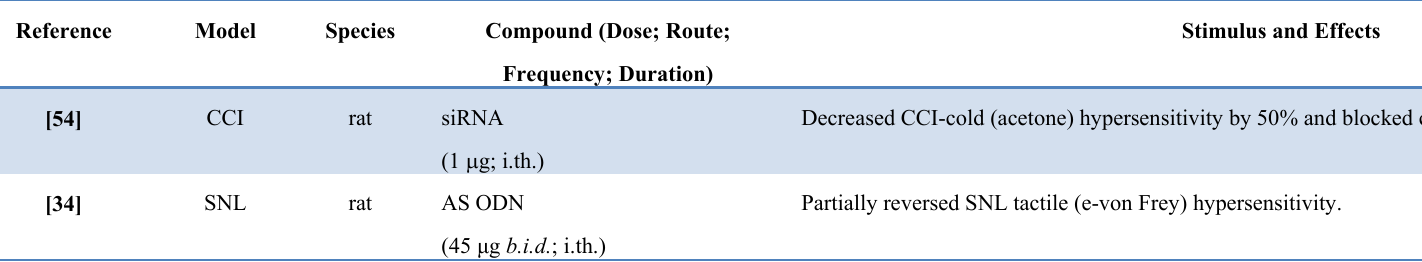
Table 2. Summary of TRPV1 Antagonists in Chronic Pain